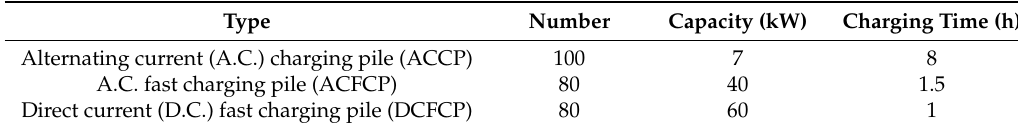
Table 6. Brief information for EV charge